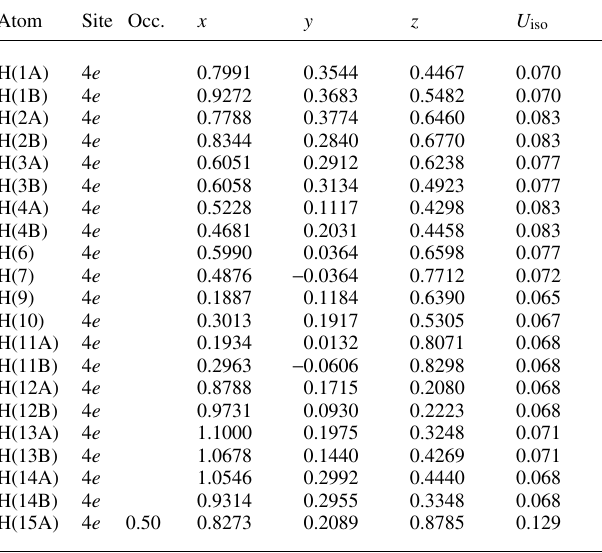
Table 2. Atomic coordinates and displacement parameters (in Å 2 )